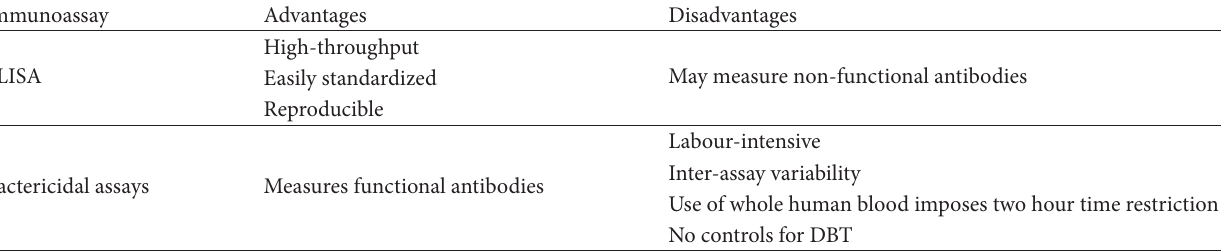
Table 1: Advantages and disadvantages of different immunoassays currently utilized in GAS